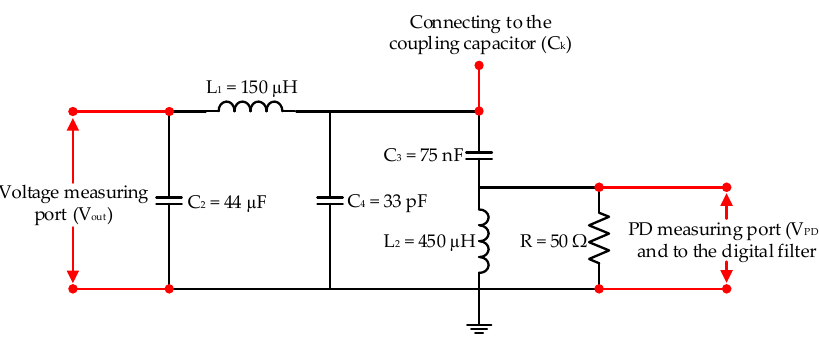
Figure 4. Equivalent circuit of the designed measuring impedance.